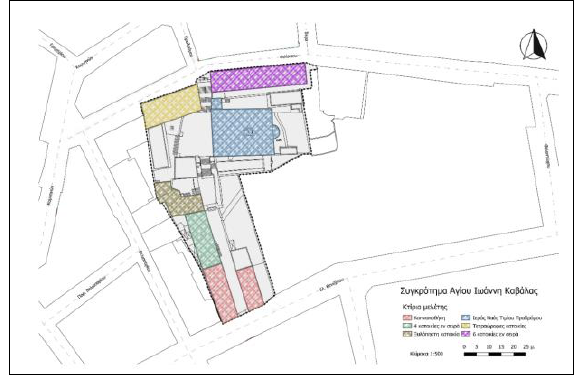
Figure 3 . Topographic map of Saint John, the Baptist, historical